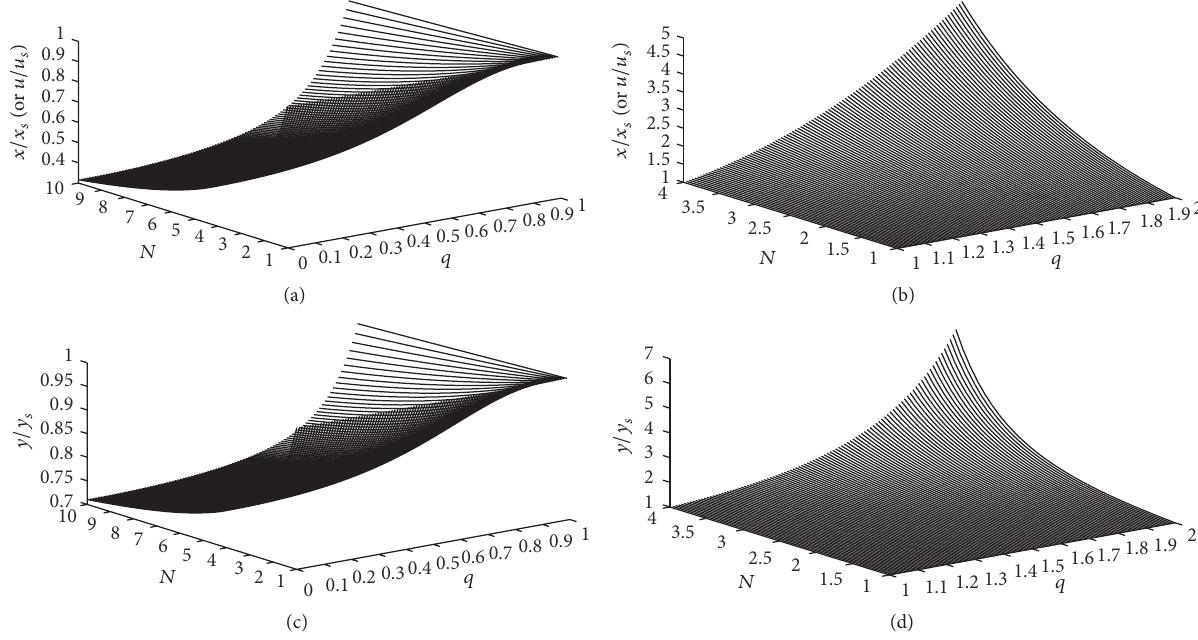
Figure 6: Behavior of the auxiliary variables 𝑥 , 𝑦 , and 𝑢 with respect to the deformation parameter 𝑞 and the particle number 𝑁